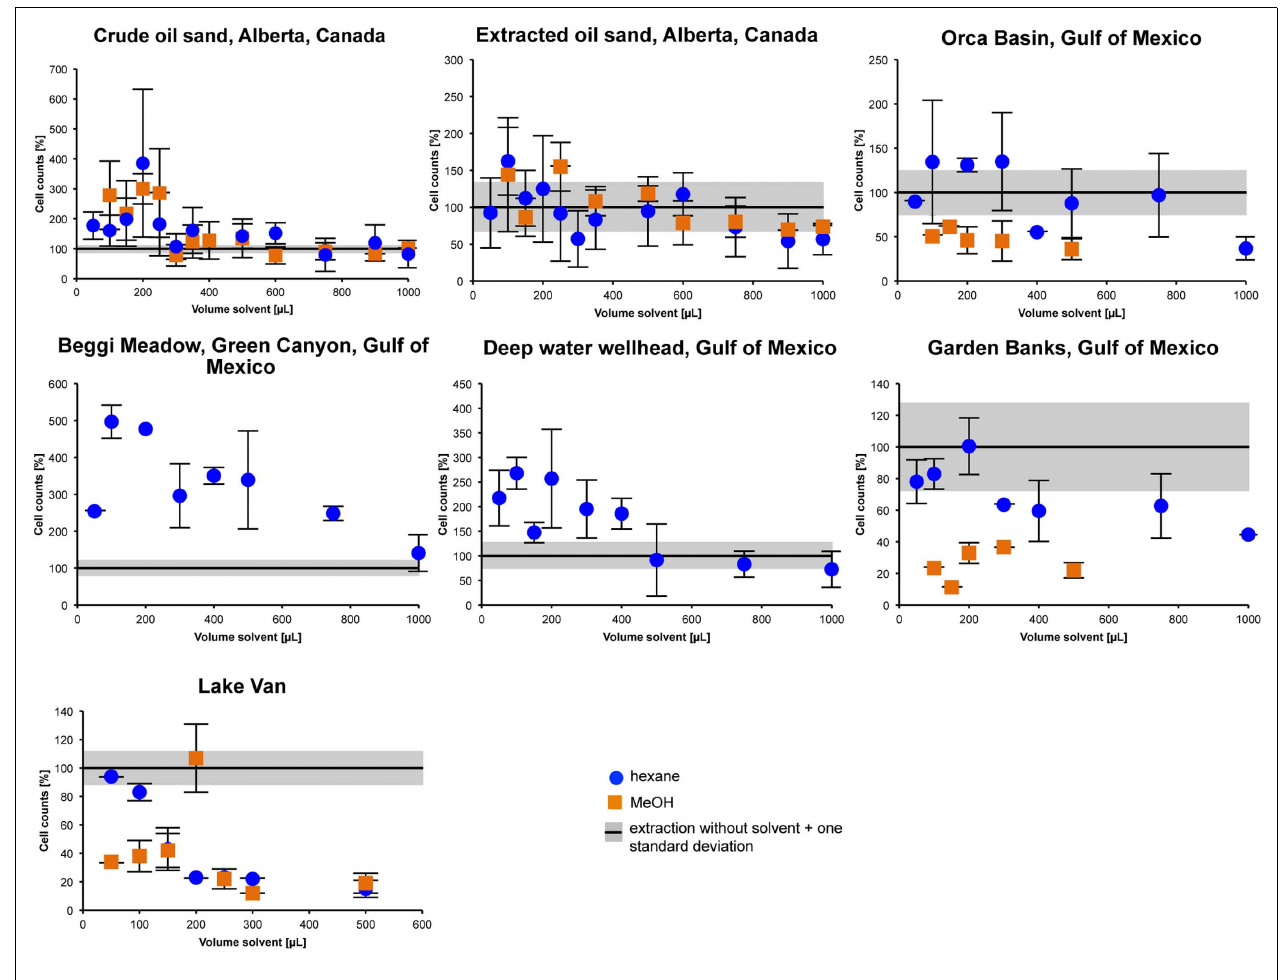
(2008). In most samples a typical pattern becomes obvious. Cell extraction efficiencies are highest for a slurry to solvent ratio of 1:2–1:5 (i.e., between 100 and 250 μ